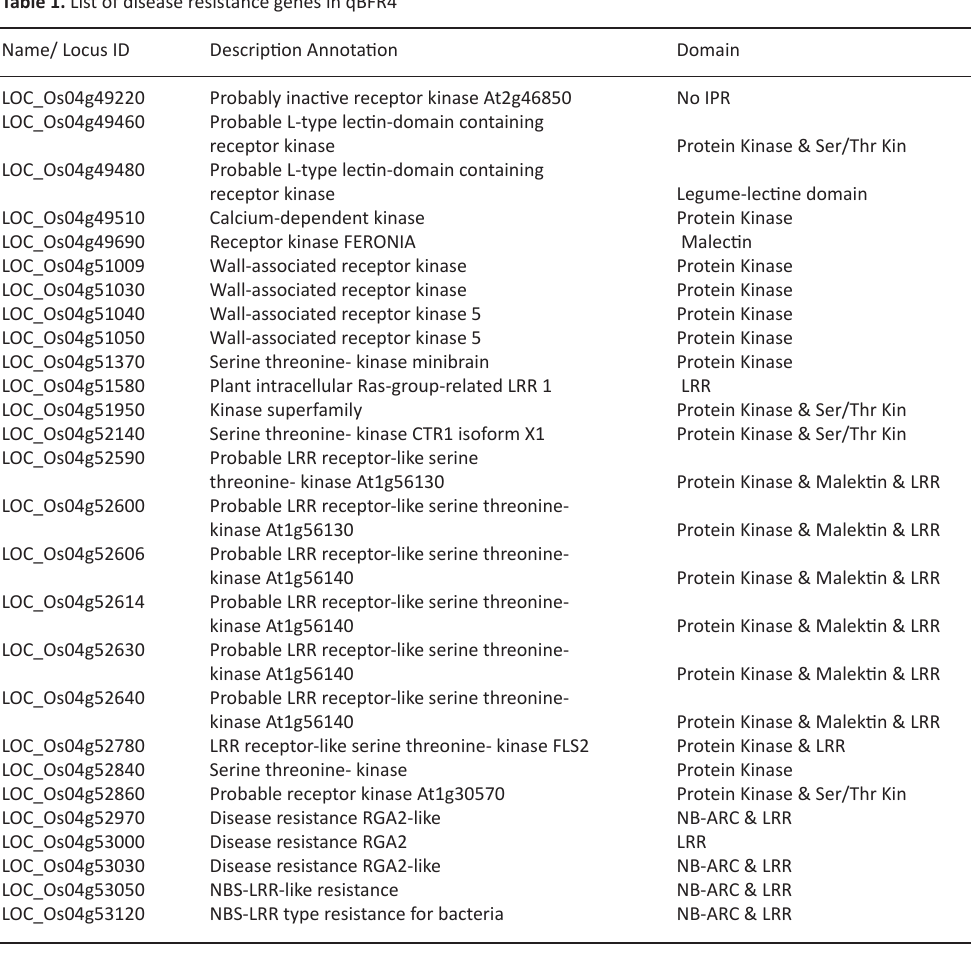
Table 1. List of disease resistance genes in qBFR4 Name/ Locus ID